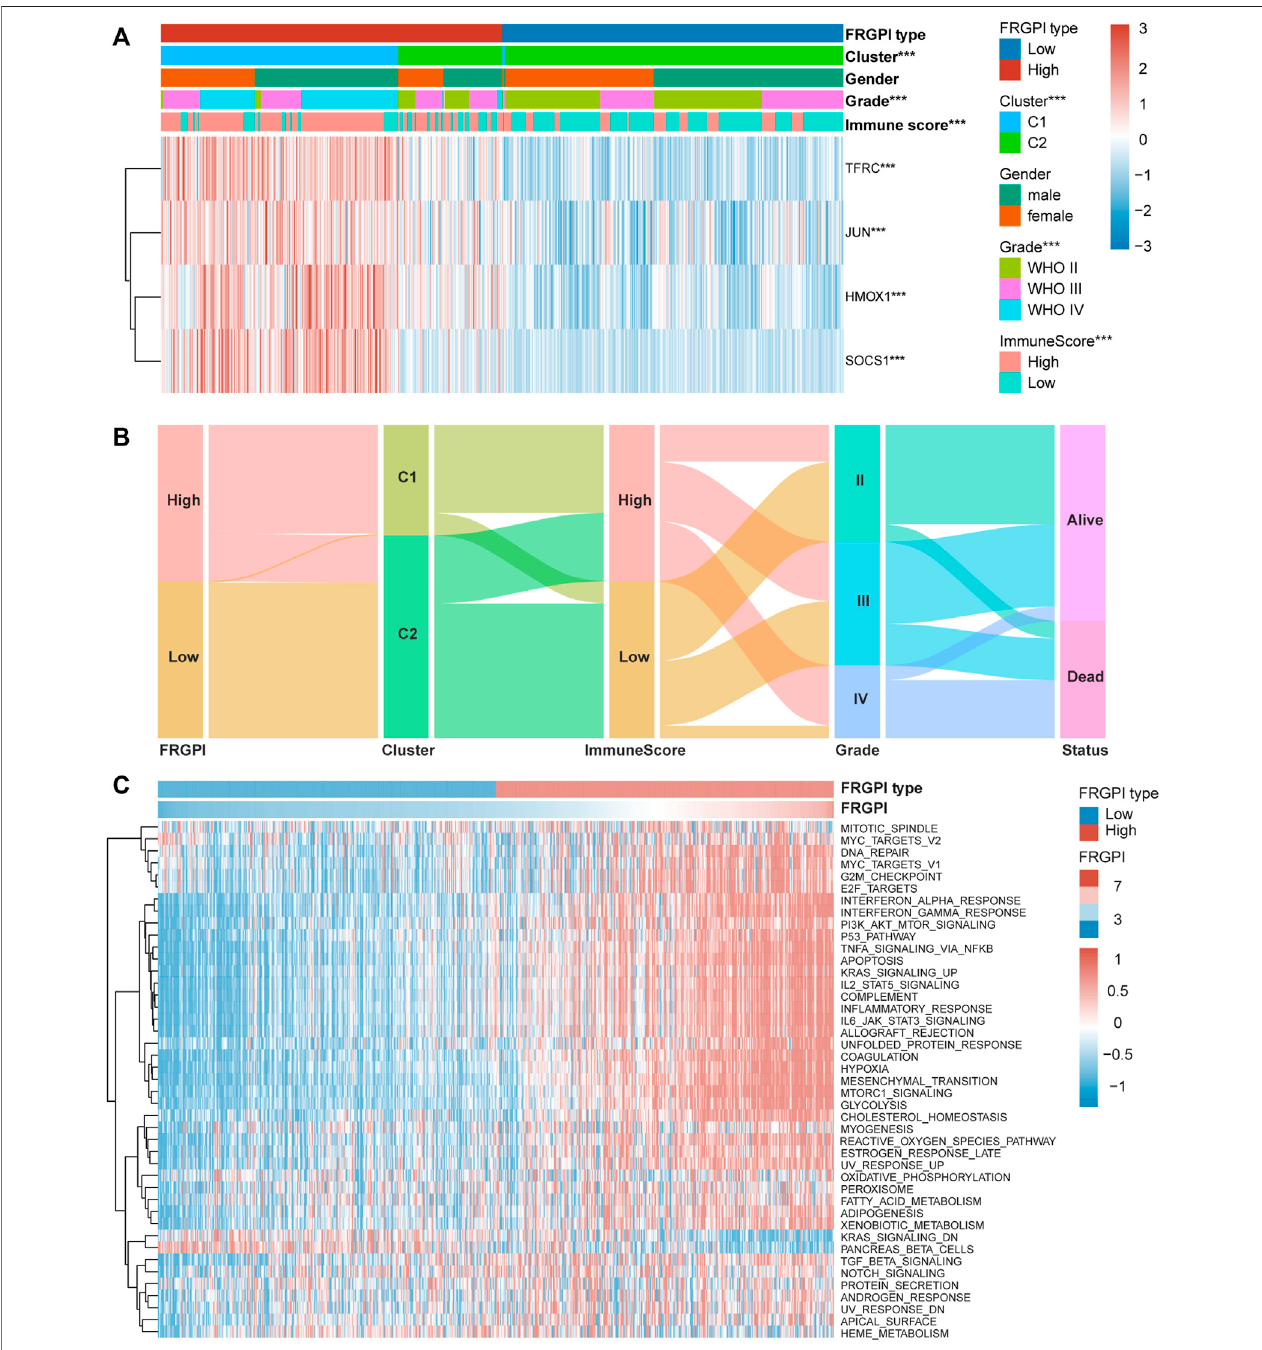
FIGURE7| HighFRGPIisassociatedwithgliomaprogression. (A) Heatmap showedthatferroptosis-relatedsubtypes,gradeandimmuneScoreweresigni fi cantly associatedwithFRGPI.* p < 0.05;** p < 0.01;*** p < 0.001. (B) TherelationshipbetweenFRGPI,ferroptosis-relatedsubtypes,immuneScore,gradeandsurvivalstatusin glioma patients was illustrated by the Sankey diagram. (C) Heatmap of Gene set variation analysis (GSVA) results between High and Low FRGPI groups.